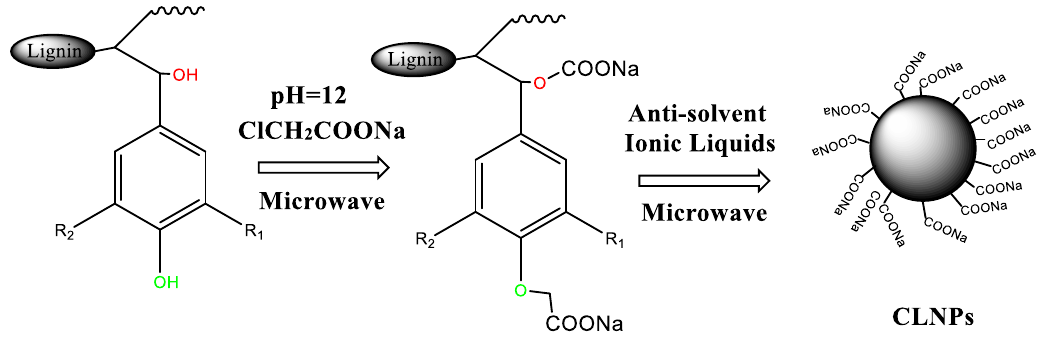
Figure 1. Schematic diagram showing the two-step synthesis of carboxymethyl lignin nanospheres